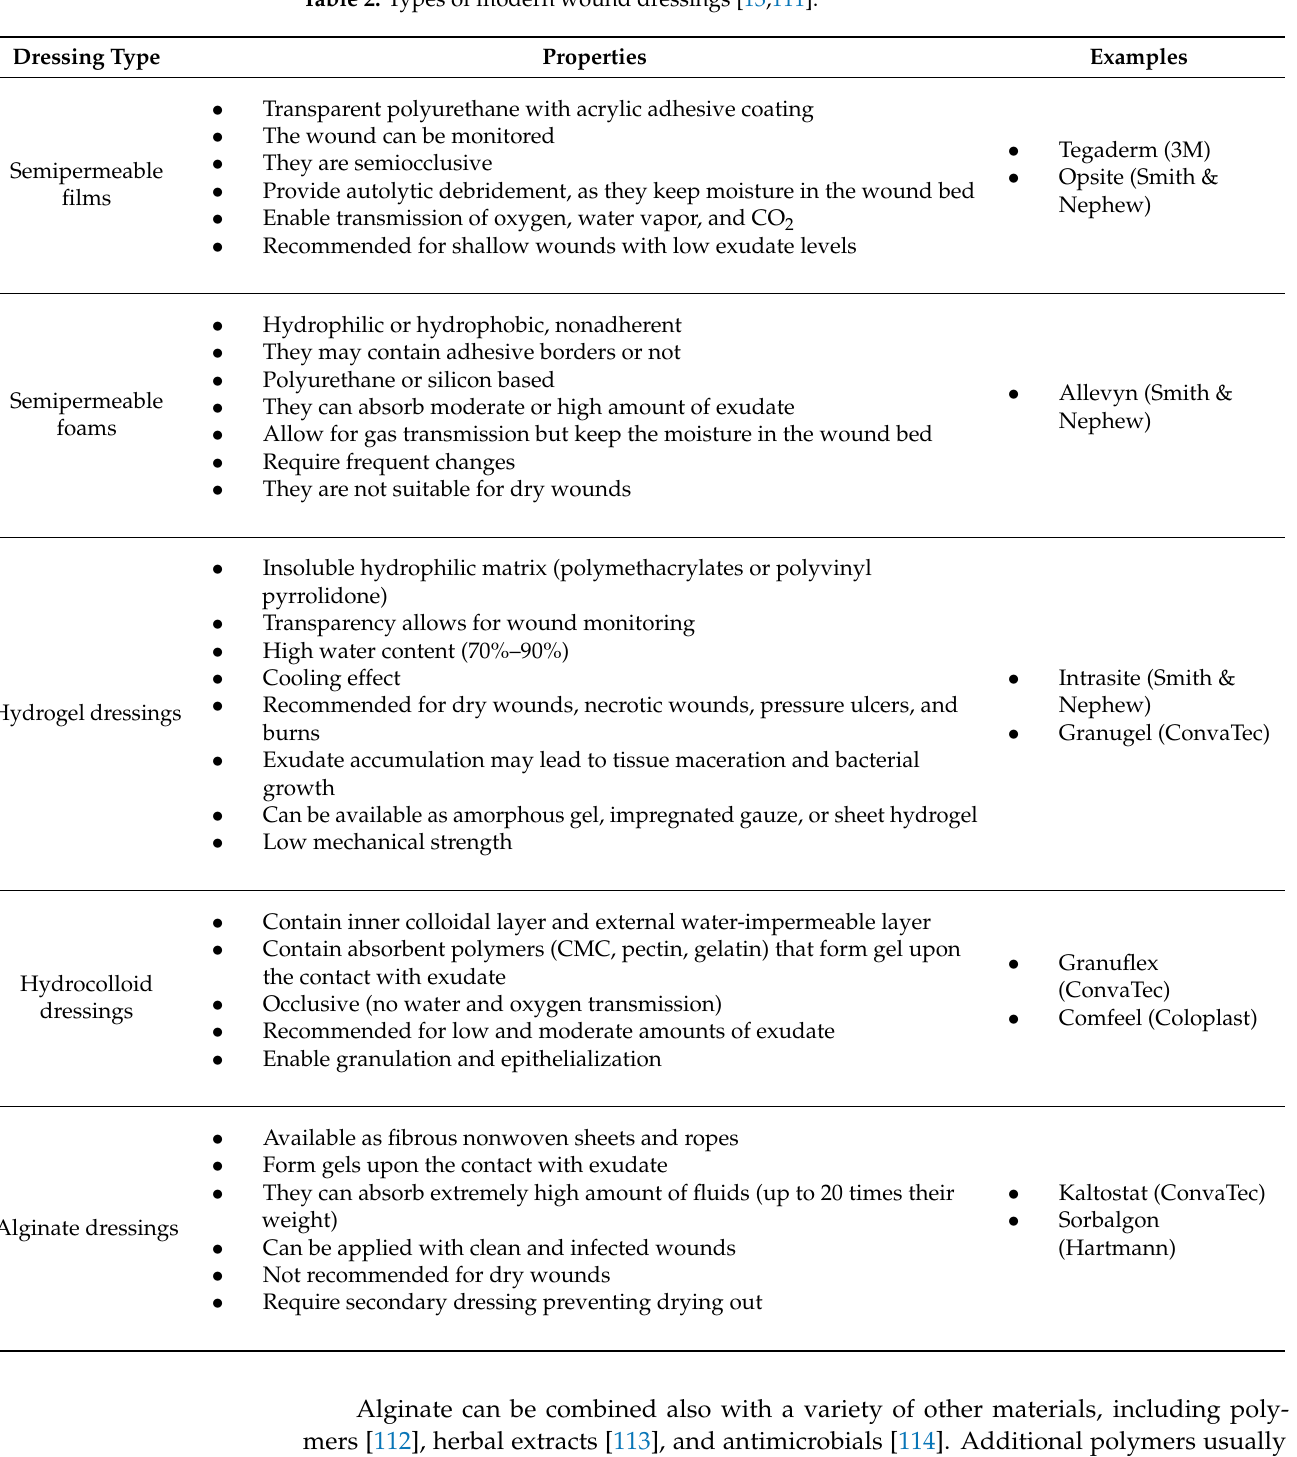
Table 2. Types of modern wound dressings